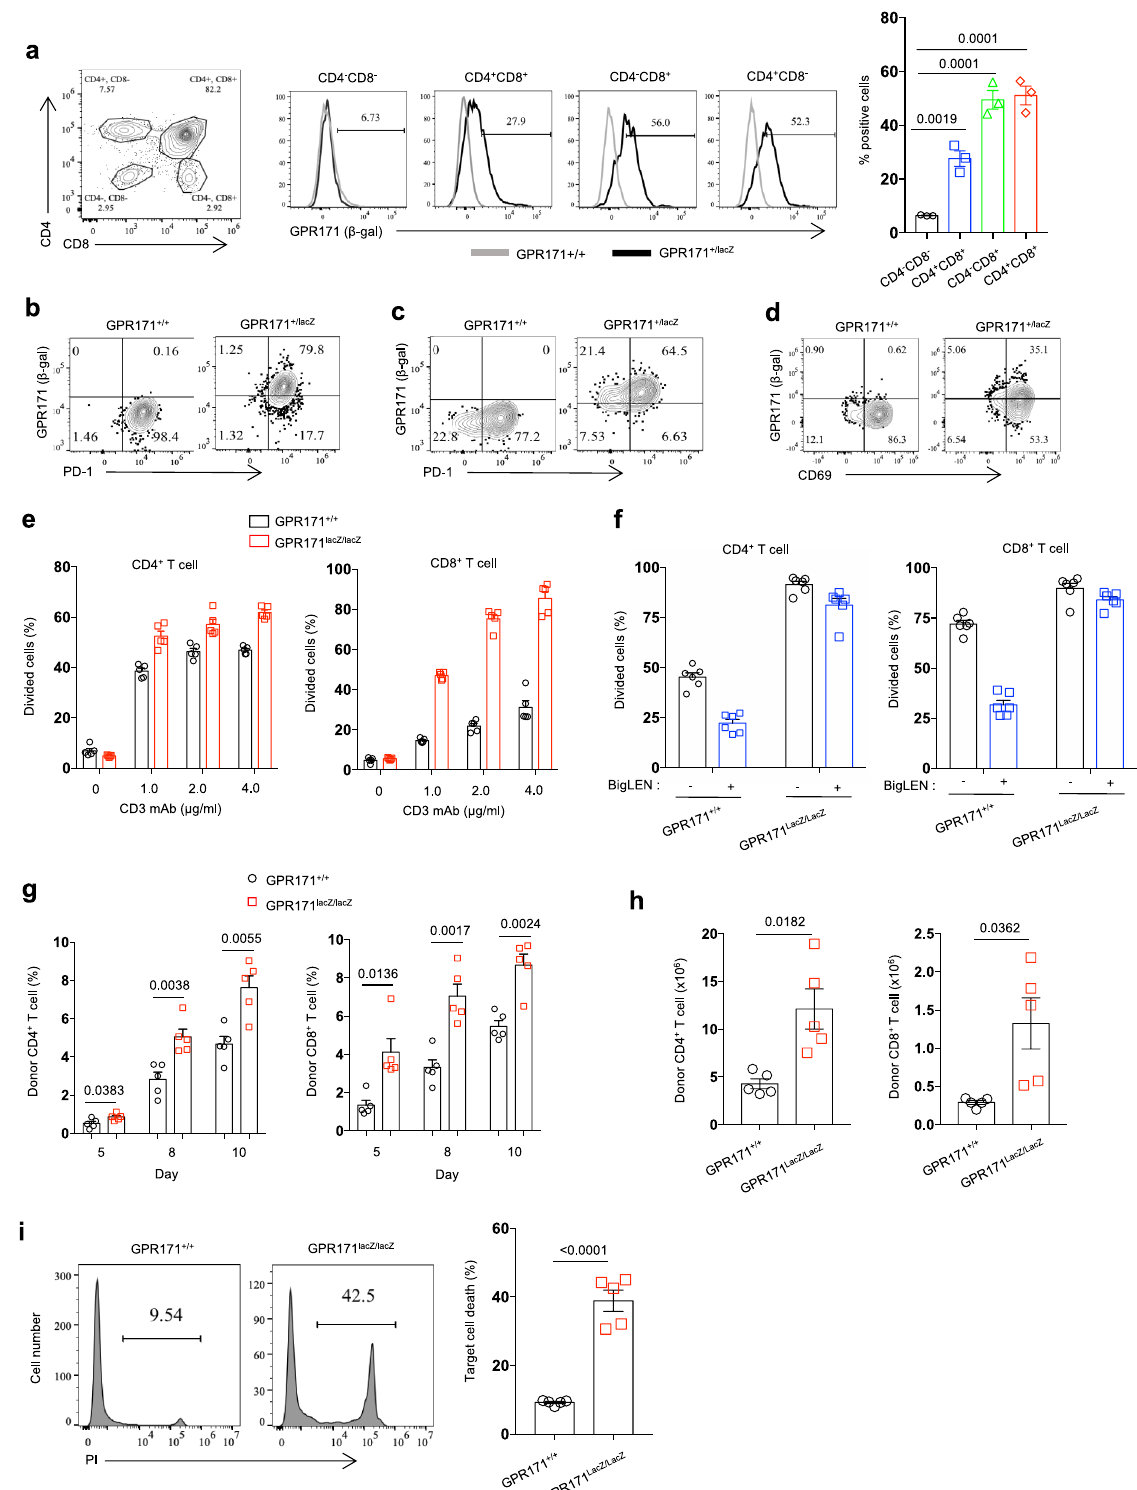
molecule granzyme B and CD137 (Fig. 4h), a key costimulatory receptor whose expression is associated with effector CD8 + T-cell activation 35 . We depleted individual immune cell subset by mAb to assess their respective role in enhanced antitumor response in GPR171 LacZ/LacZ mice. As shown in Fig. 4i, the depletion of either CD8 + or CD4 + T cells completely abolished the antitumor effect in GPR171 LacZ/LacZ mice while the removal of NK cells